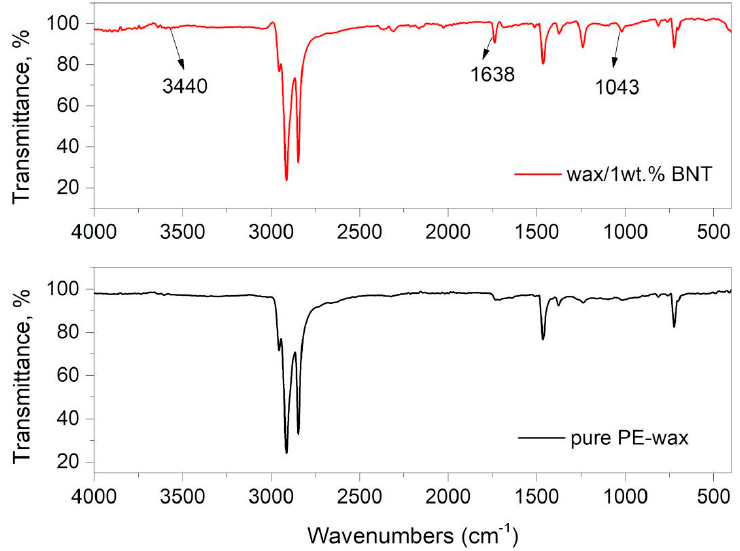
Figure 13. FT-IR spectra of PE-wax with 1 wt.% BNT blend (red curve) and pure PE-wax.